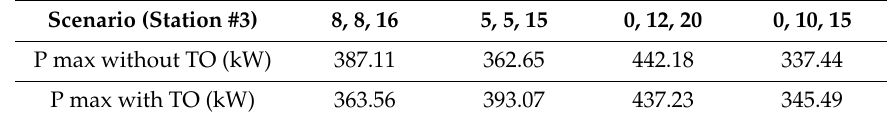
Table 6. Peak power load value at station #3 for di ff erent scenarios.